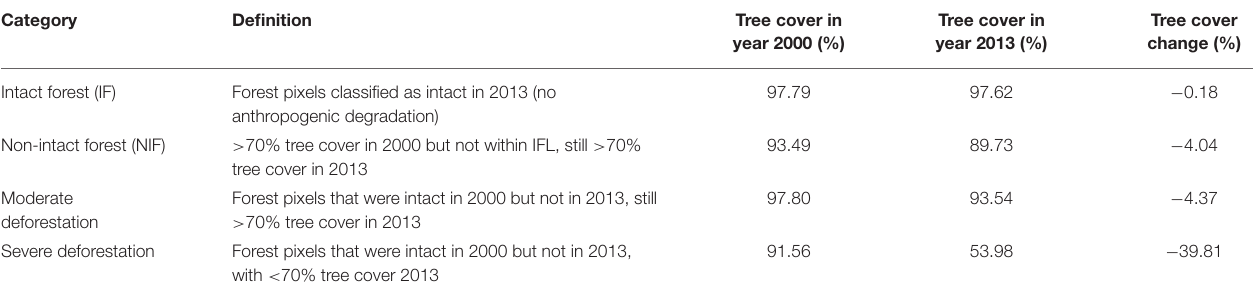
TABLE 1 | Forest disturbance categories used in this